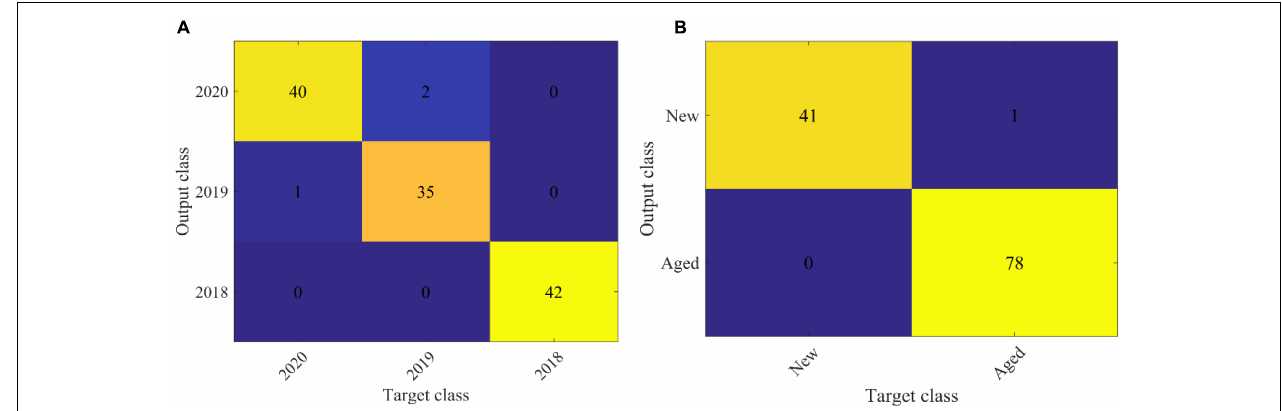
FIGURE 6 | The confusion matrix of the data fusion model based on embryo side spectra. (A) is the classification results of maize seed harvested in 2018, 2019 and 2020. (B) is the classification results of new (2020) and aged (2018 and 2019) maize